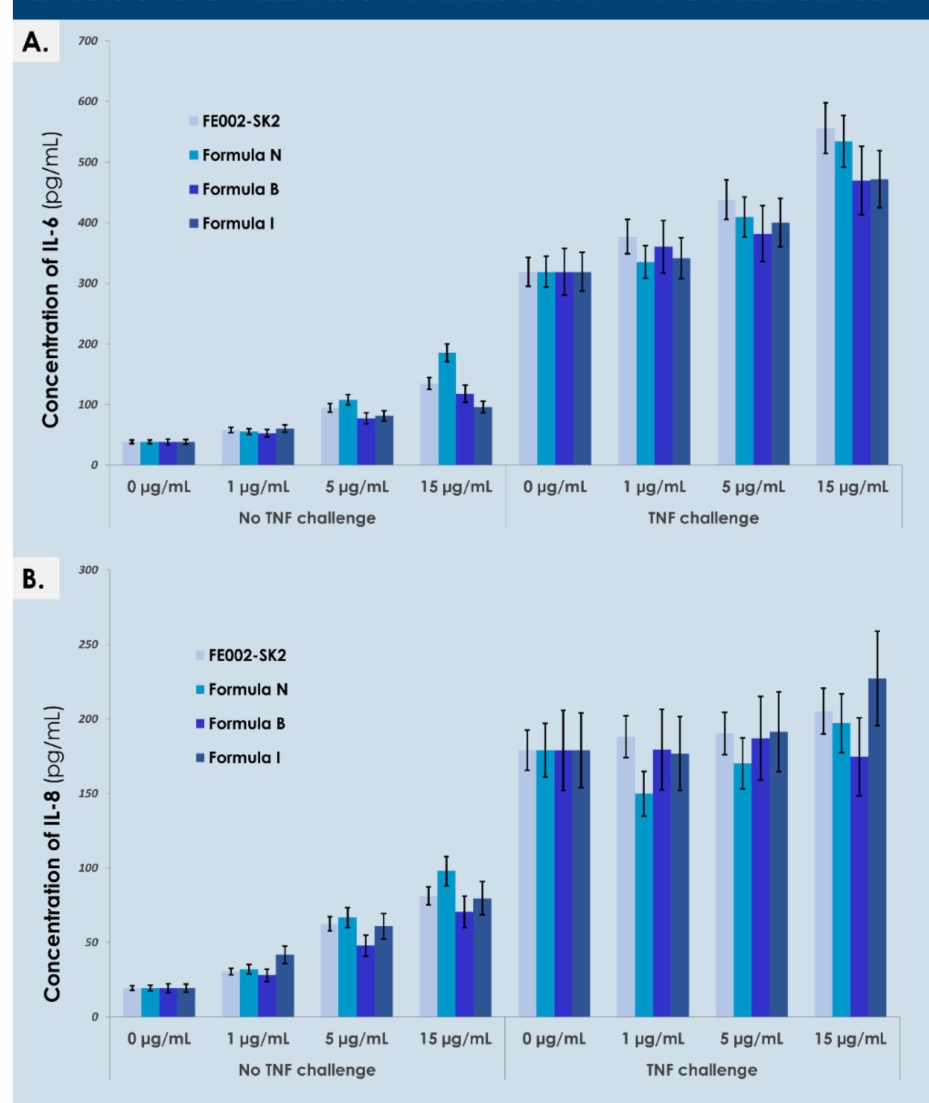
Figure 9. Effects of dermal FPC lyophilizates on interleukins in a TNF challenge assay. Adult fibroblasts were expanded, treated with various doses and formulations of lyophilized dermal FPCs (i.e., using fresh FE002-SK2 lysate as a control), and stimulated for 24 h with 10 ng/mL TNF- α . Thereafter, the levels of IL-6 and IL-8 were quantified in cell culture supernatants by ELISA. ( A ) Comparative results of IL-6 quantification for both assay conditions (i.e., with or without TNF stimulation). ( B ) Comparative results of IL-8 quantification for both assay conditions (i.e., with or without TNF stimulation). ELISA, enzyme-linked immunosorbent assay; FPC, fibroblast progenitor cells; TNF, tumor necrosis